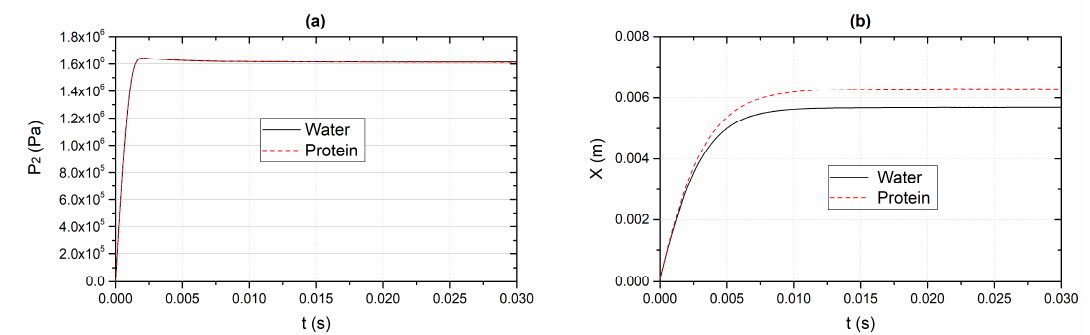
Figure 5. Comparison of the start-up characteristics due to the change in fluid medium—water and protein: ( a ) Outlet pressure P 2 ; ( b ) poppet displacement X . For these simulations: q e = 8 L / s and P 1 = 1.6 MPa.